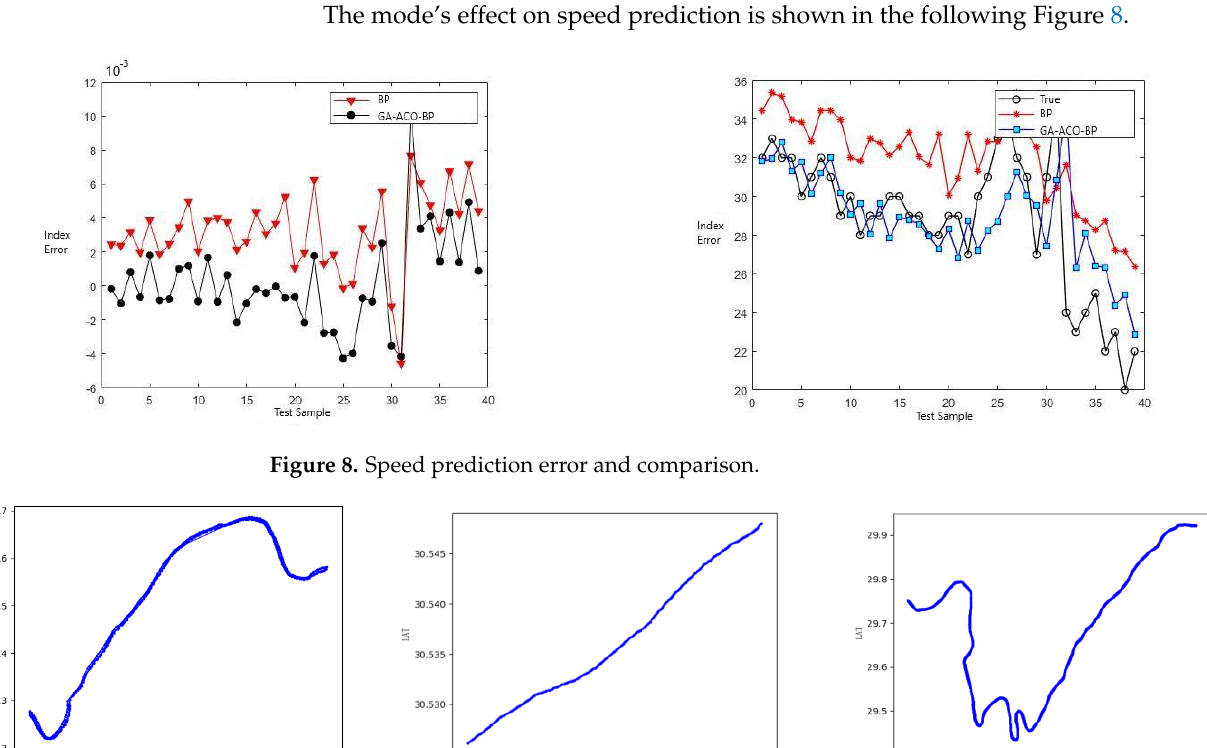
Figure 7. Latitude prediction error and comparison (GA – ACO – BP).